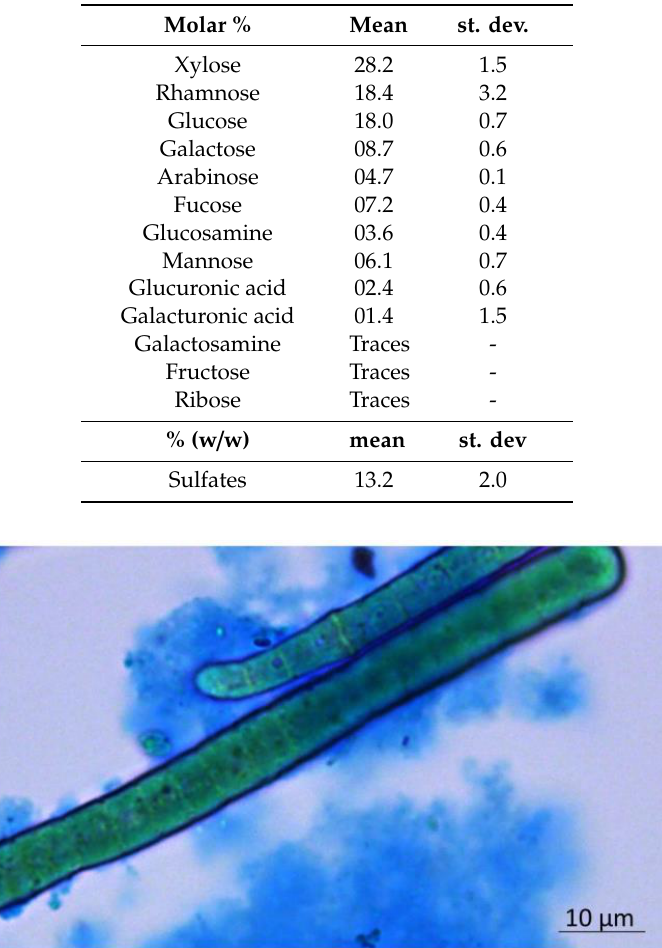
Table 1. Monosaccharidic composition (as molar %, listed from the most to the least abundant) and sulfate groups (measured as % in weight) quantification of EPS from Phormidium sp. ETS05. Mean and standard deviation (st. dev.) for triplicates are reported.